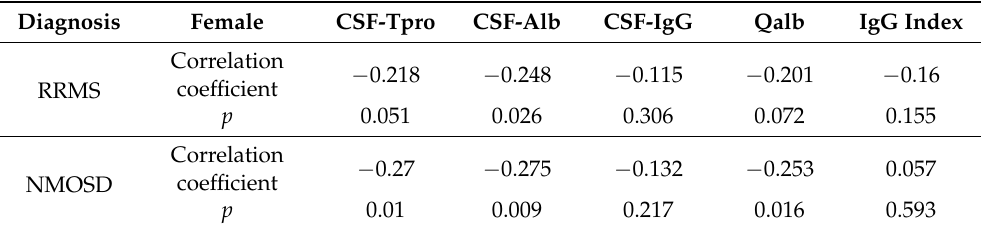
Table 3. Spearman’s correlation analysis of the sex-related difference in the CSF protein levels between RRMS and